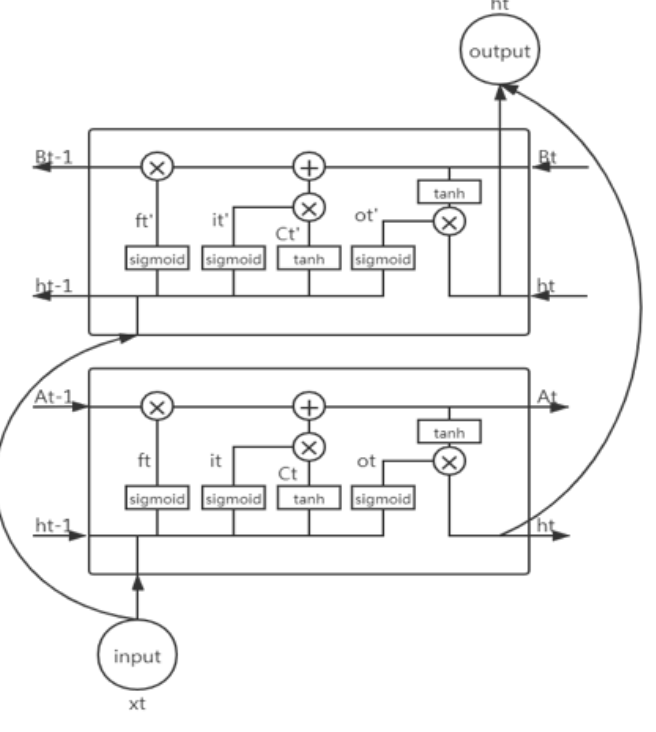
Figure 3. BiLSTM